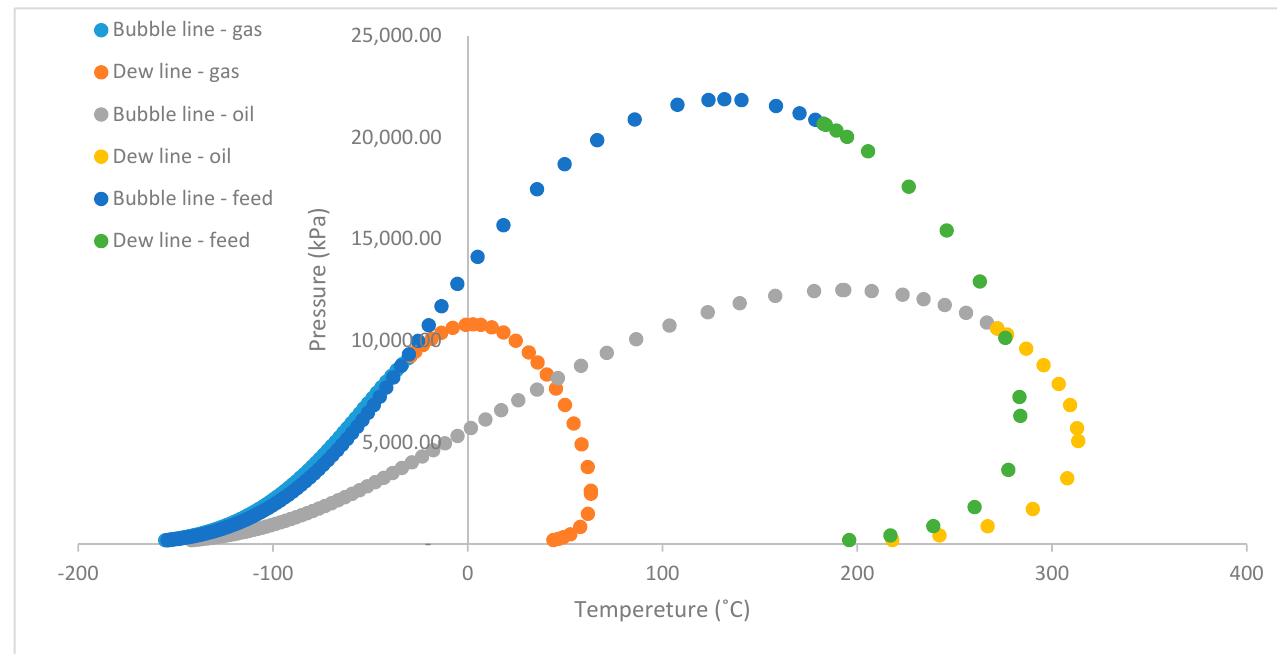
Figure 6. Phase envelopes of feed stream, gas stream, and oil stream obtained from HYSYS.